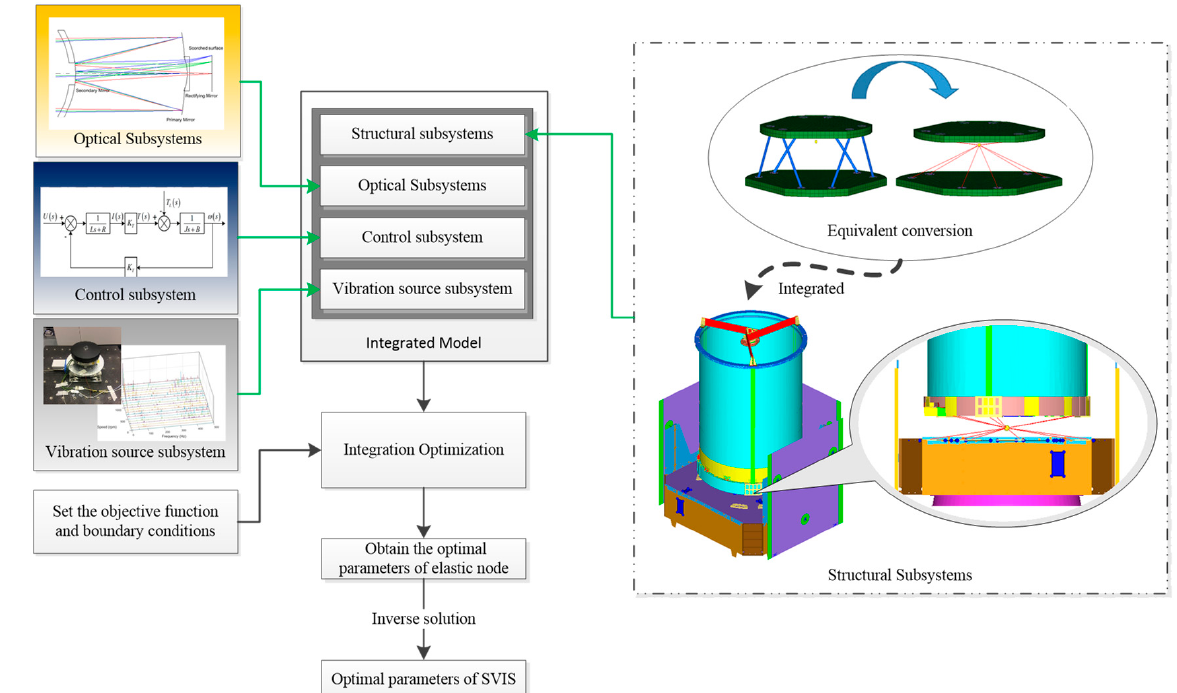
Figure 7. Integrated optimization design process of SVIS.